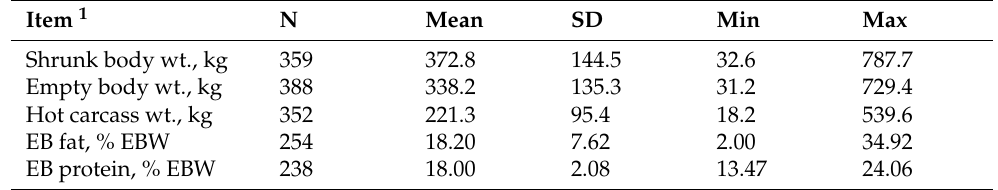
Table 1. Summary statistics of body weight and chemical composition of cattle in the Weight dataset.